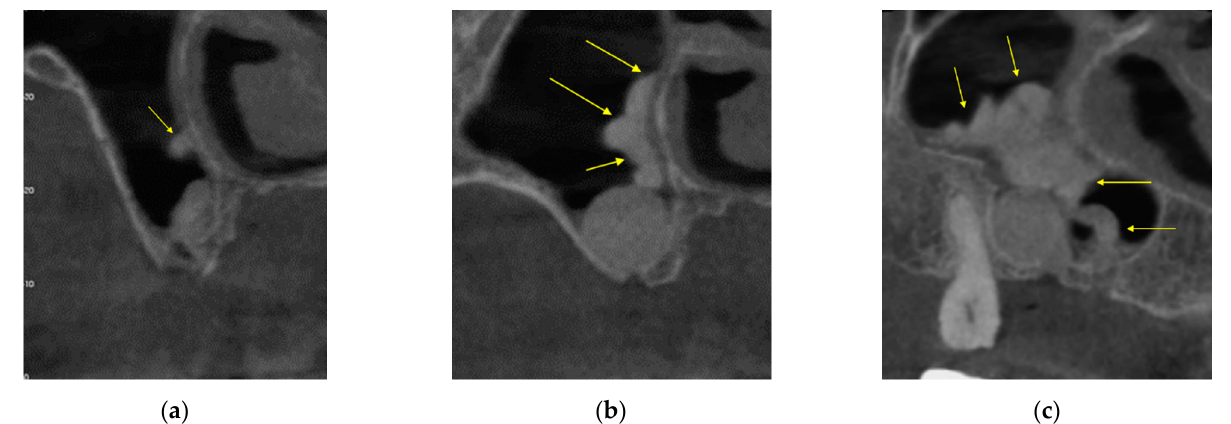
Figure 6. Patient #2. Immediately postoperative CBCT showing membrane perforation occurred at the second premolar site ( a ), whereas a regular “dome-shaped” lift of the membrane was obtained in the first molar area ( b ). Panorex ( c ) shows a significant amount of gel graft dispersed into the sinus cavity through a membrane perforation remained undetected during surgery. Dispersed biomaterial is indicated in ( a – c ) by the arrows.